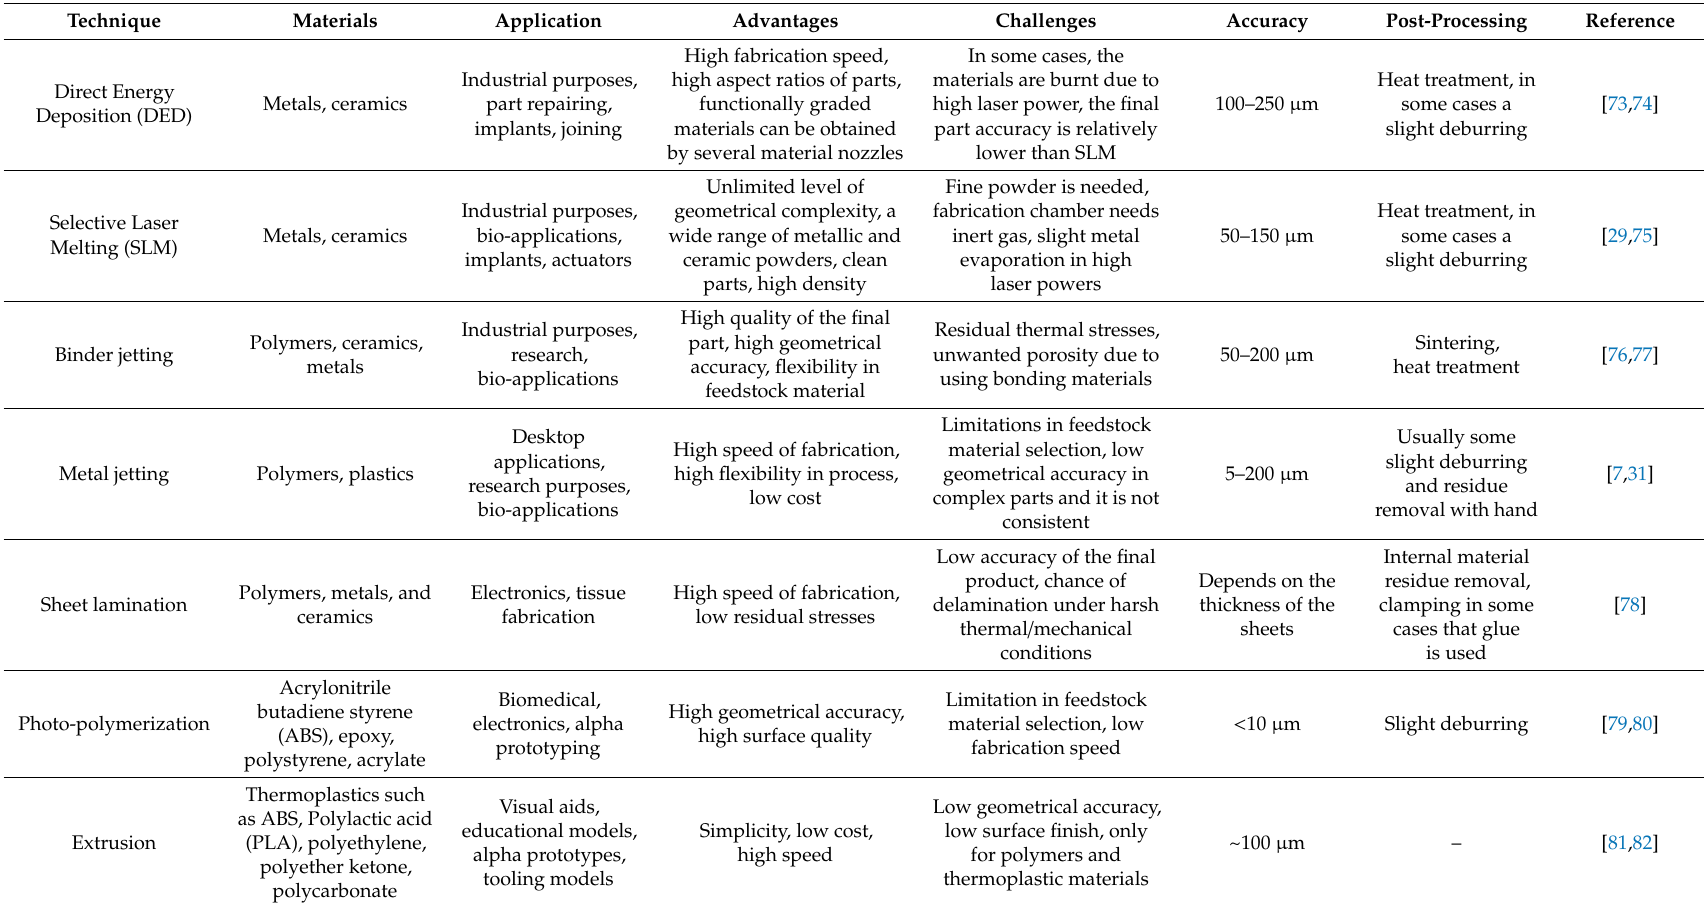
Table 2. Summary of di ff erent techniques of AM, materials used, and other properties of these